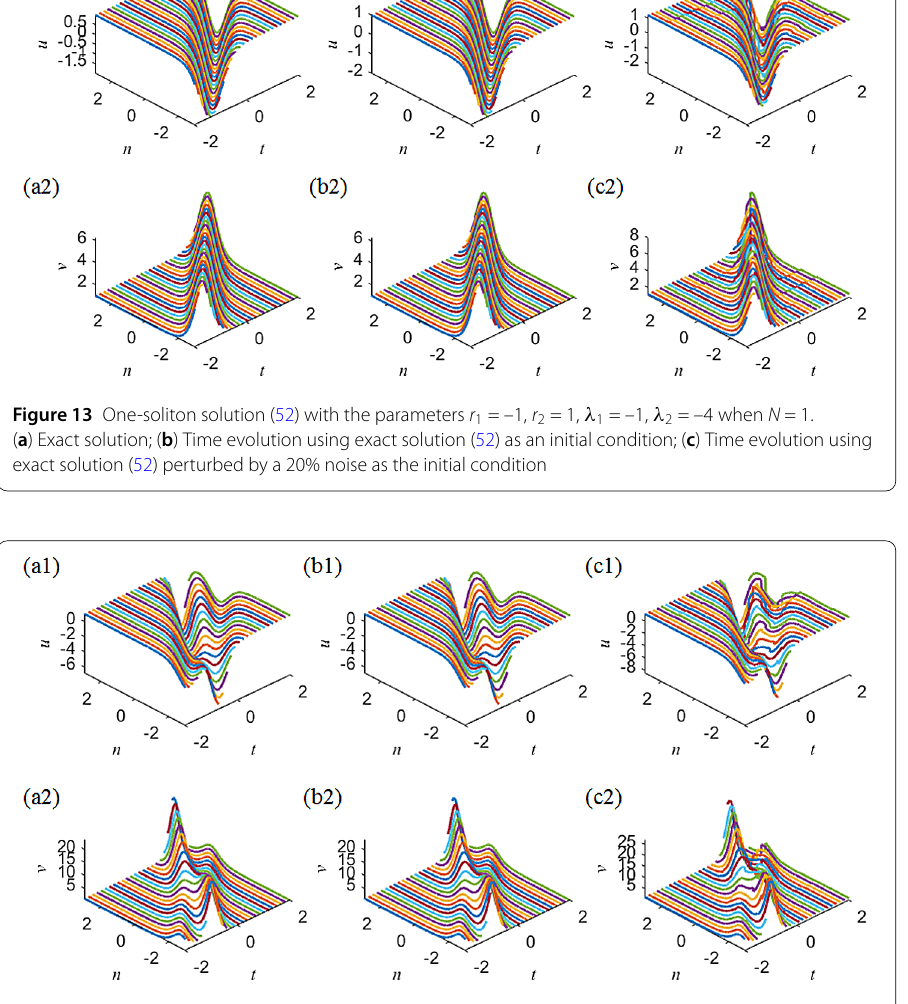
u n and v n components), the numerical results in Figs. 13–16(c1)–(c2) show that they can evolve as before, that is to say, these soliton solutions (52) of Eq. (1) are robust against a relatively big noise (20 % ). In fact, when adding a 30 % noise to their initial solutions, the simulated evolutions of these soliton solutions exhibit very small